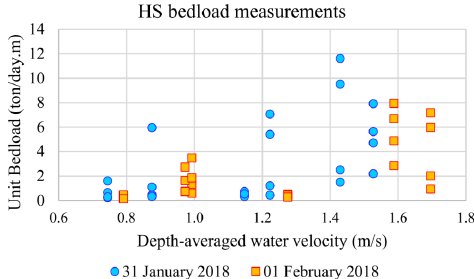
cross-section P1, in Taquari River.